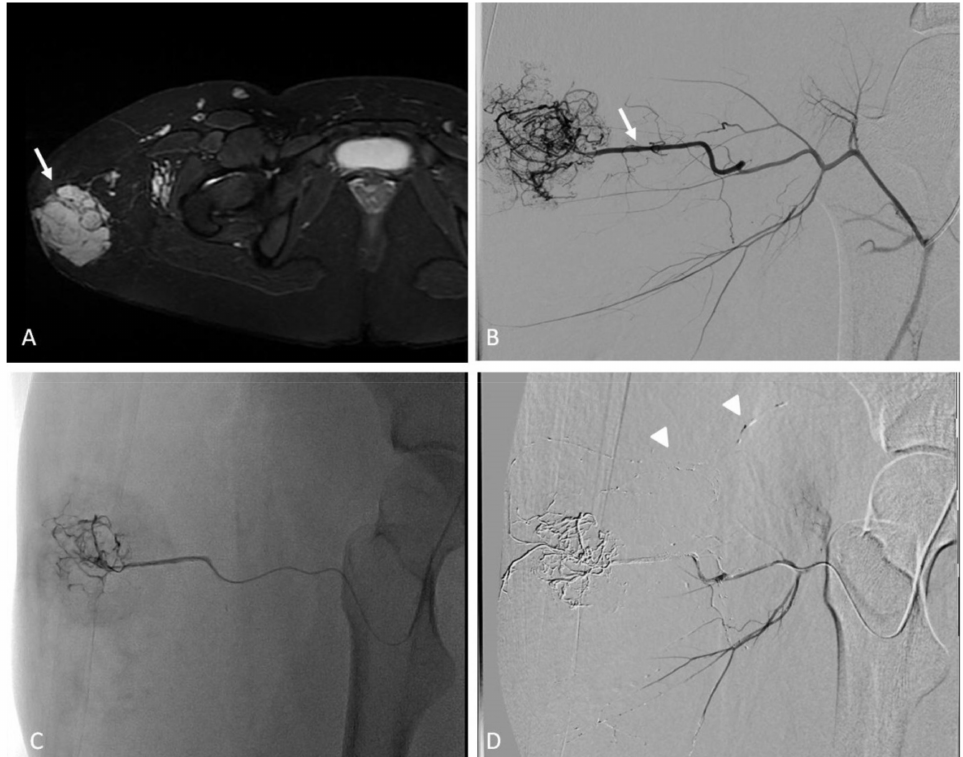
Figure 4. Transcatheter ethylene vinyl alcohol (EVOH) copolymer embolization of a simple high-flow vascular malformation of the thigh in a 16-year-old female. ( A ) Magnetic Resonance Angiography T2-weighted image shows a hyperintense mass consistent with a vascular malformation (arrow). ( B ) Selective DSA of the deep femoral artery confirms the high-flow nature of the vascular malforma- tion with a prevalent feeder (arrow). ( C ) Fluoroscopy image, acquired during EVOH embolization after superselective 2.7F coaxial microcatheterization of the lateral circumflex artery, shows capillary distribution of the embolic agent throughout the lesion. ( D ) Control DSA confirms the complete devascularization of the malformation; note little embolic material spread into the draining veins of the lesion